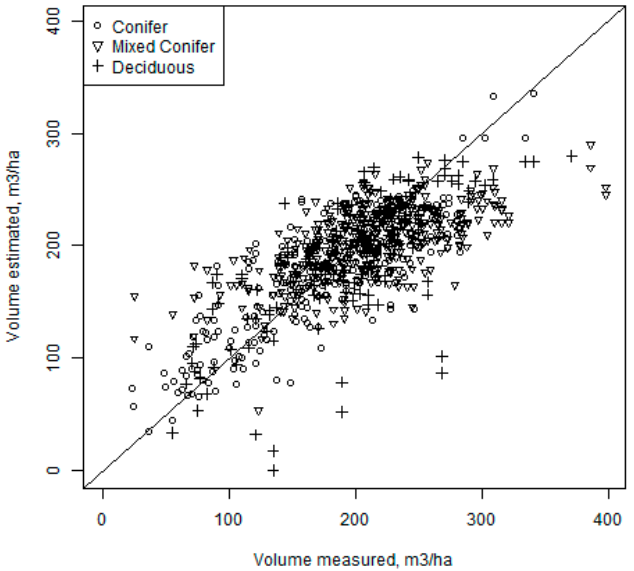
Figure 8. Scatter plot of field-measured and estimated mean volume at plot level.